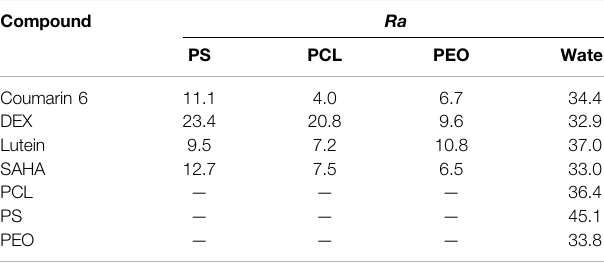
TABLE 2 | Hansen solubility parameter distance ( Ra ) between drug compounds and hydrophobic BCP blocks and water. Lower values indicate greater compatibility.